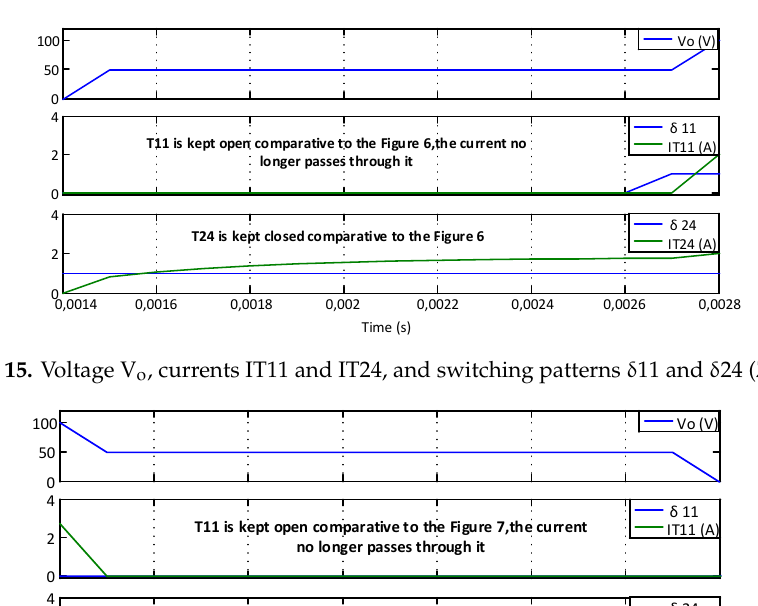
Figure 14. Output voltage of the converter with the proposed OPT-PWM control.